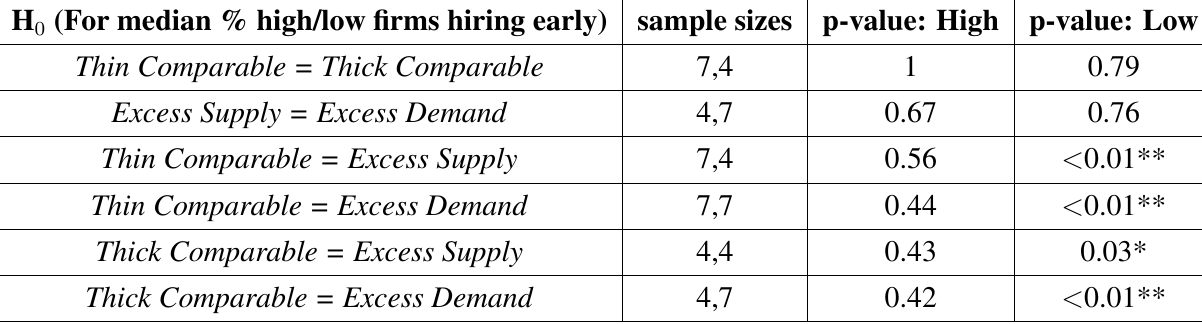
Table 3. Testing equivalence of high firm and low firm early hiring percentages in the last five markets. We denote significance regarding the rejection of the null hypotheses at 95% level with * and significance at 99% level with ** after the reported